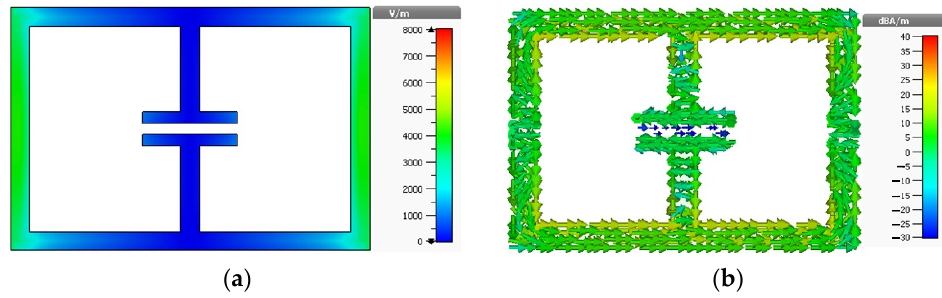
Figure 5. Distribution of ( a ) electric field and ( b ) current densities at 4.23 GHz for Setup 2.